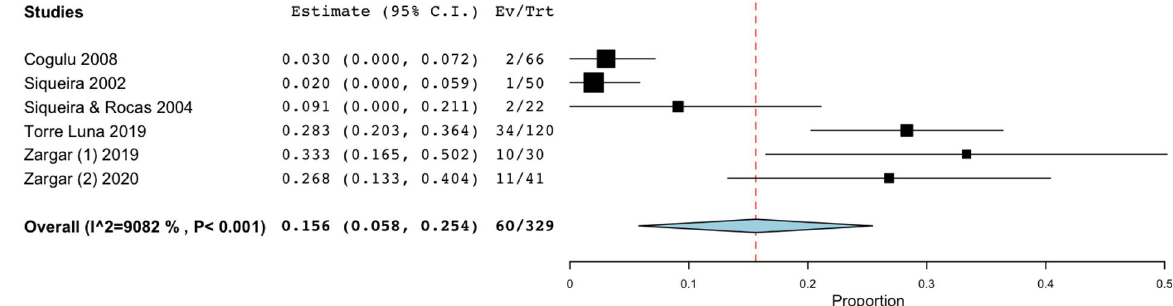
Fig 5. Forest plot representing fungal species prevalence in studies using both paper point and hand files for sample collection from teeth with primary and secondary endodontic infections.